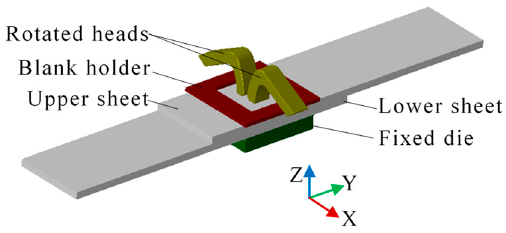
Figure 2. Finite element model of the rotated clinching process.